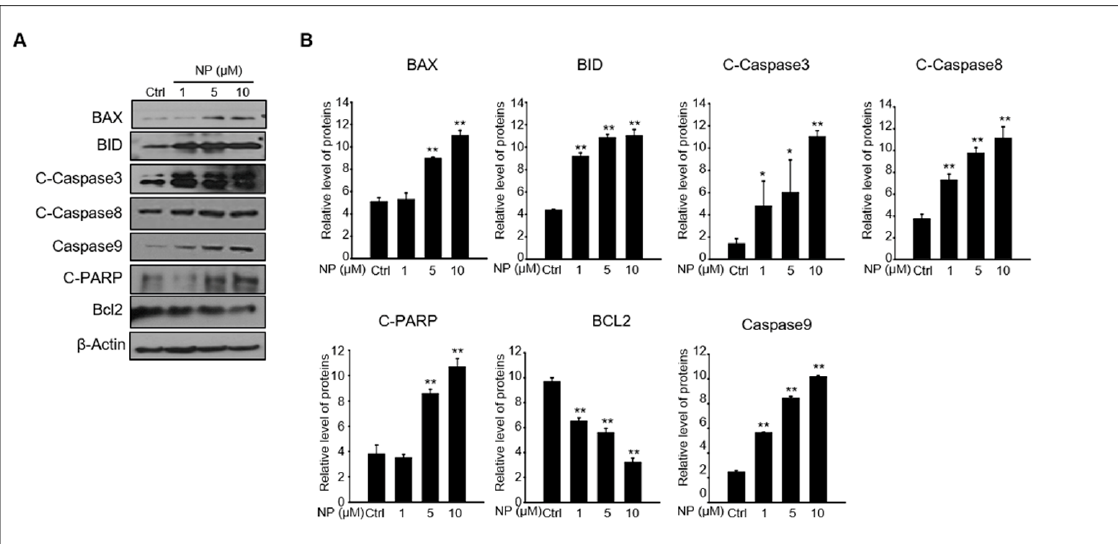
Figure 2. The effects of NP on pro-apoptotic protein expression in GC-1 spg cells. ( A ) The protein expression levels of BAX, BID, cleaved caspase-3 and caspase-8, cleaved-PARP, BCL2, caspase 9, and β -actin in GC-1 spg cells after treatment with 0, 1, 5, and 10 μ M NP for 24 h. ( B ) Quantitative analysis of BAX, BID, cleaved caspase-3 and caspase-8, cleaved-PARP, BCL2, and caspase 9 protein expression levels. Graphs represent the relative density of each protein band normalized to that of β -actin. Data are presented as the mean ± SD of three independent experiments ( n = 3, * p < 0.05 and ** p < 0.01 compared to the controls).